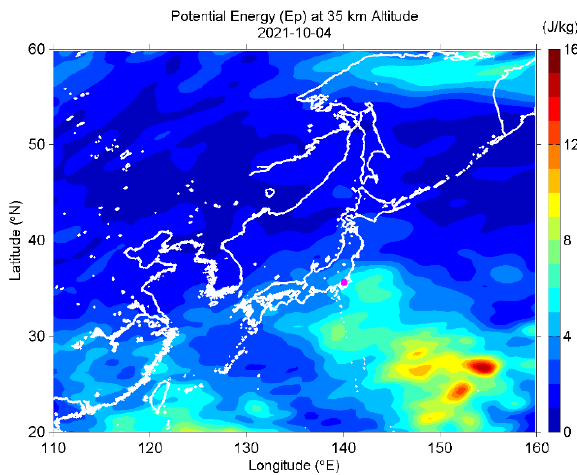
Figure 14. The E p map at 35 km altitude on 4 October.